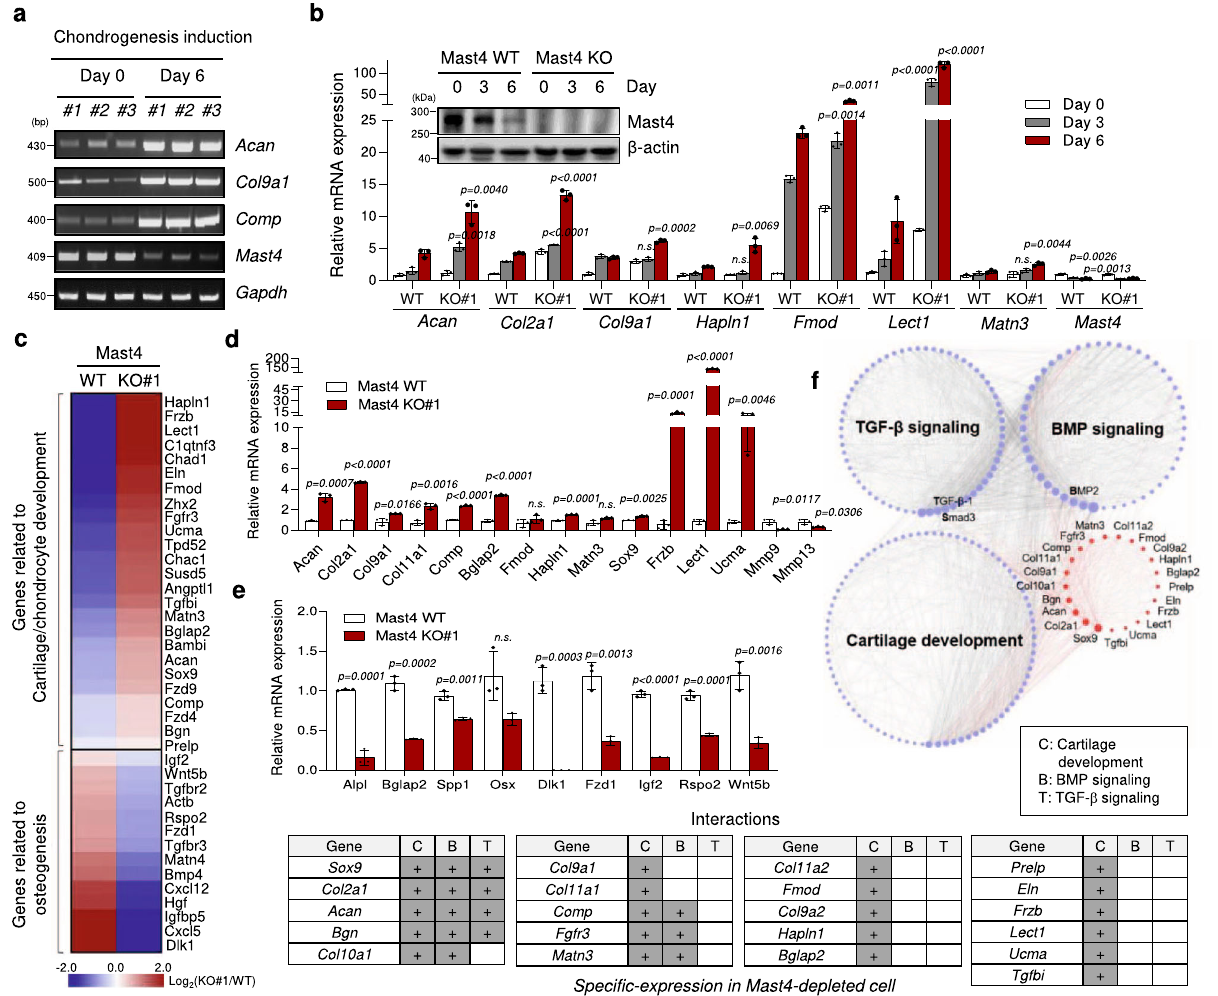
Fig. 1 Targeted deletion of the Mast4 gene enhances cartilage matrix gene expression and reduces osteogenic gene expression in vitro. a Representative RT-PCR result, obtained from at least three independent experiments, of high-density micromass culture of C3H10T1/2 cells in the presence of BMP-2. b Representative qRT-PCR result of the expression of chondrocyte marker genes in the differentiating wild-type and Mast4-depleted C3H10T1/2 cells. Mast4 protein expression was con fi rmed by western blot during chondrogenic differentiation. c Heatmap of DEGs, classi fi ed under cartilage/chondrocyte development and osteogenesis, of chondrogenic differentiated wild-type and Mast4-depleted C3H10T1/2 cells for 6 days. d Representative qRT-PCR result of Sox9-targeted genes and Mmp9 / 13 , which were identi fi ed by RNA sequencing, in wild-type and Mast4-depleted C3H10T1/2 cells differentiated to chondrocytes for 6 days. e Representative qRT-PCR result of osteoblast marker genes and the genes related to osteogenesis, which were identi fi ed in c , in wild-type and Mast4-depleted C3H10T1/2 cells differentiated to osteoblasts for 10 days. f Transcriptional network of the DEGs related to cartilage and chondrocyte development, TGF- β signaling, and BMP signaling in the wild-type and Mast4-depleted C3H10T1/2 cells differentiated to chondrocytes for 6 days. The node size was set on the basis of connectivity of the nodes. Red-colored circles indicate genes showing differential expression in Mast4-depleted C3H10T1/2 cells. b , d and e Data are representative mean ± SD of three independent experiments, each conducted in triplicate ( n = 3). Unpaired two-tailed Student ’ s t test ( P < 0.05) with Benjamini-Hochberg correction for multiple tests was conducted for all statistical analyses. P values versus WT at corresponding day; n.s. not signi fi cant. Uncropped blots in a , b are shown in Source Data fi le. Source data for b , d and e are provided as a Source Data fi